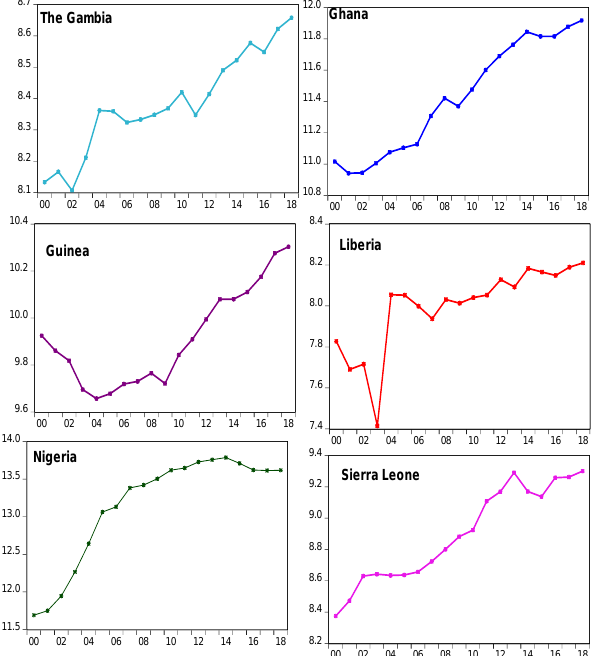
Figure 3: The Nature of Economic Growth in the Selected